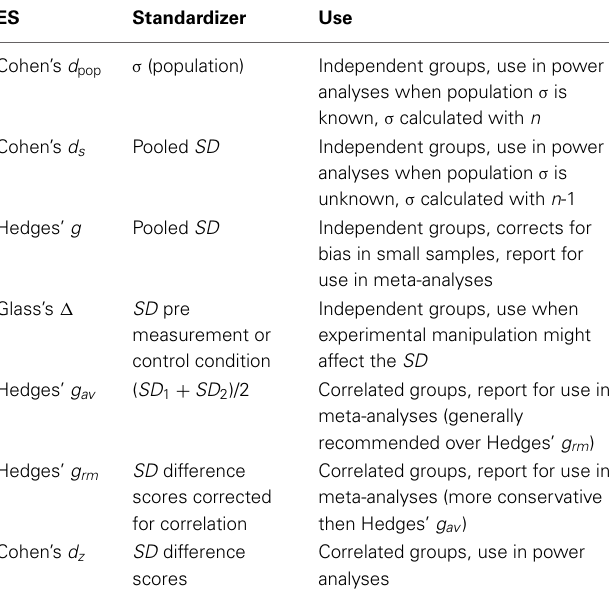
Table 1 | Summary of d family effect sizes, standardizers, and their recommended